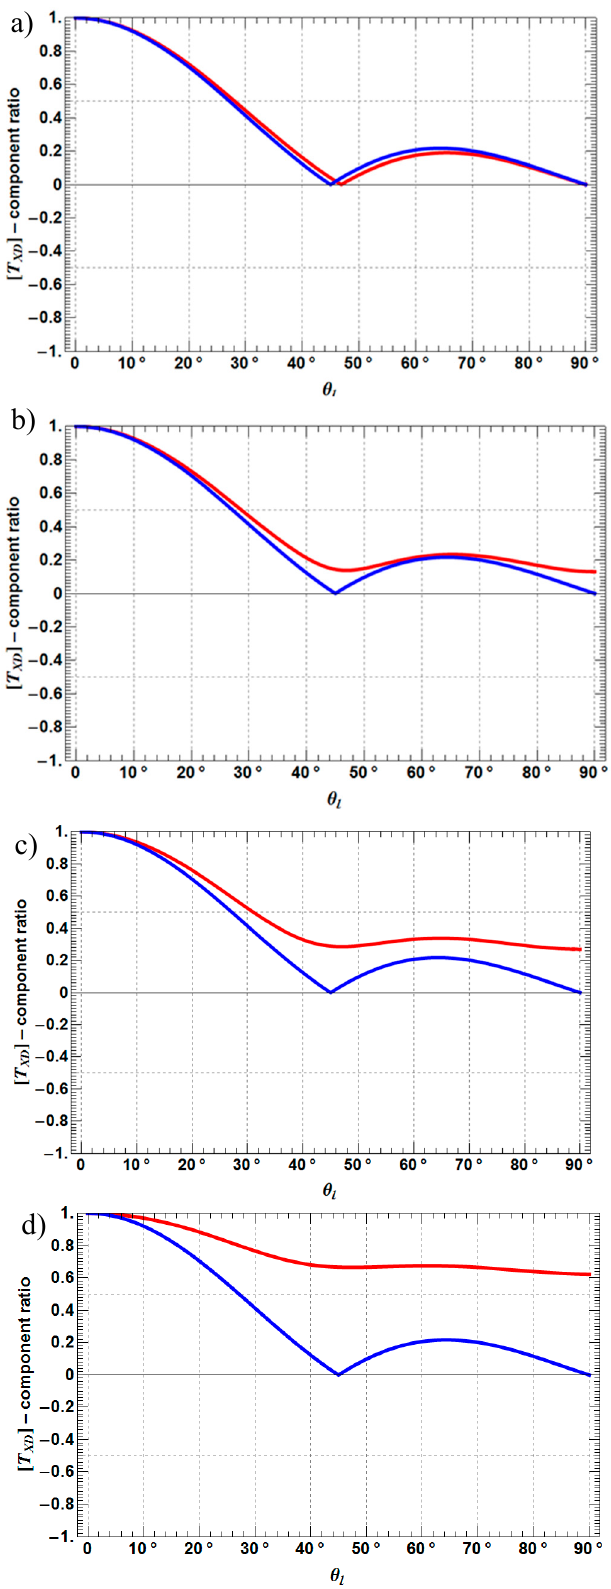
Figure 24. Sensitivity of |( T XD22 - T XD33 )/( T XD22 + T XD33 )| along roughness angle θ 1 (red) ( ε s = 20, ε t = 10, ω l = 30 ◦ , L SXD = 1) with differential phases φ = 0 ◦ ( a ), φ = 15 ◦ ( b ), φ = 30 ◦ ( c ), φ = 60 ◦ ( d ) and comparison with |sinc (4 θ 1 ) |